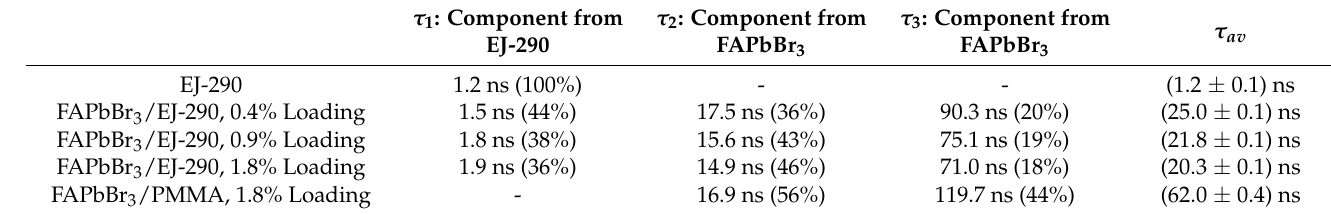
Table 1. Time constants for FAPbBr 3 nanocomposite